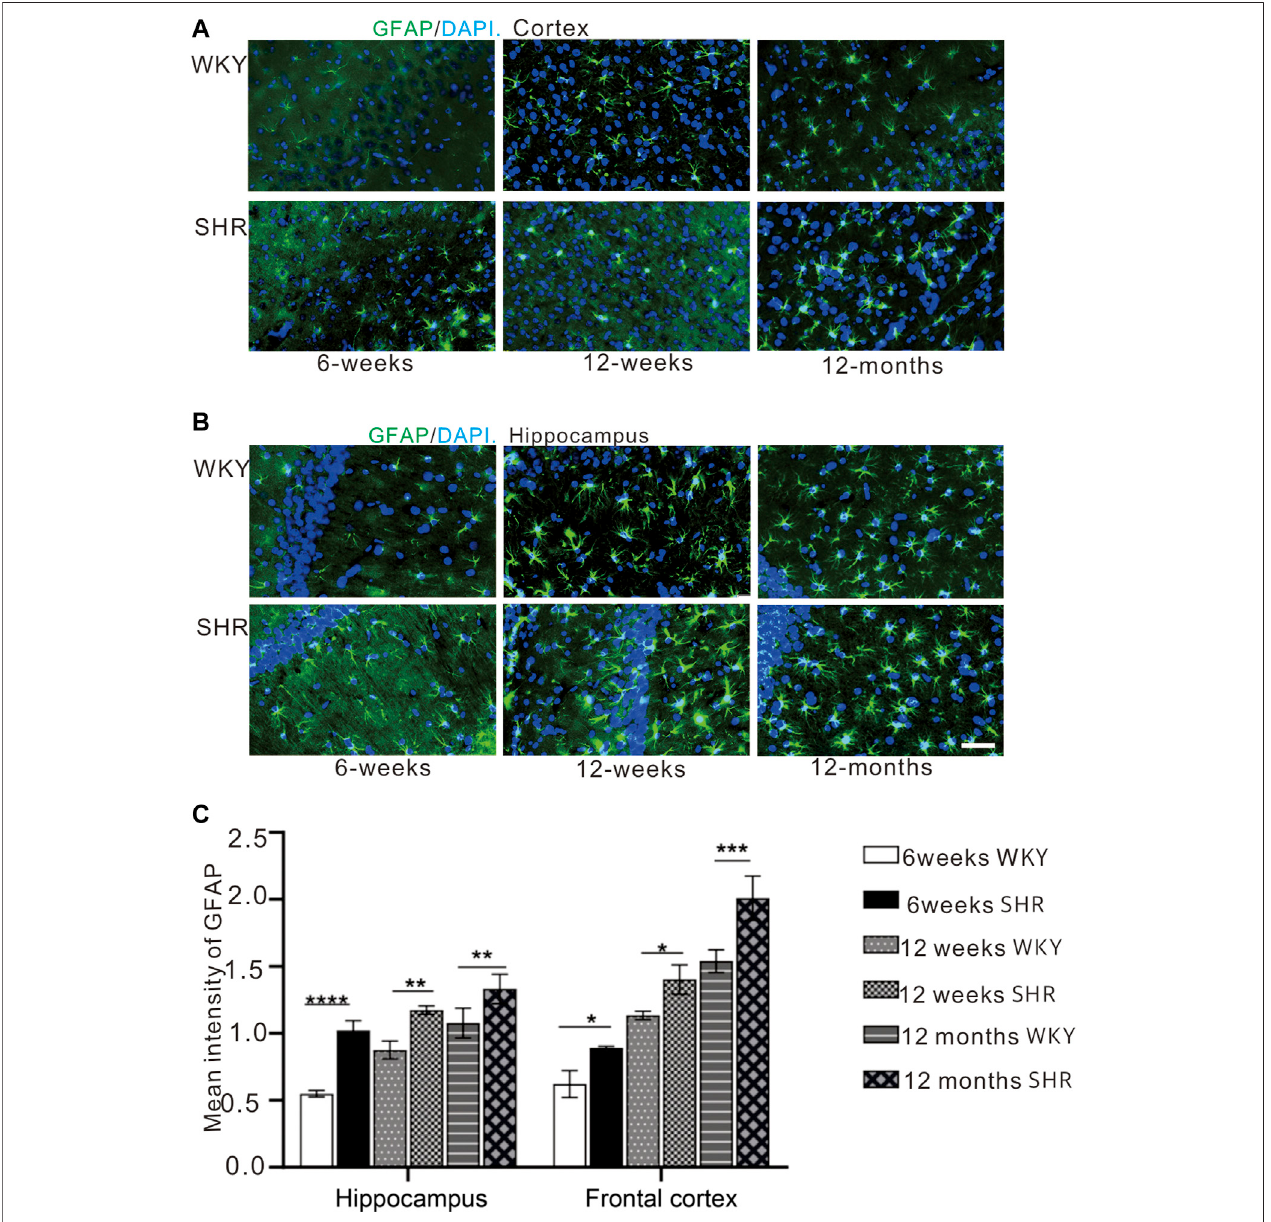
FIGURE 5 | GFAP immuno fl uorescence showed that the expression of GFAP in the cortex and hippocampus of SHR rats was increased compared with that of WKY rats. (A) the expression of GFAP in prefrontal cortex of WKY and SHR, (B) the expression of GFAP in hippocampal CA1 of WKY and SHR, bar = 20 μ m *p < 0.05 versus age-matched WKY control. **p < 0.01, age-matched WKY control. ***p < 0.001 age-matched WKY control. The values represent mean ± SD. (C) The mean intensity of GFAP was upregulated in the SHR at each age-matched group in the hippocampus and frontal cortex.